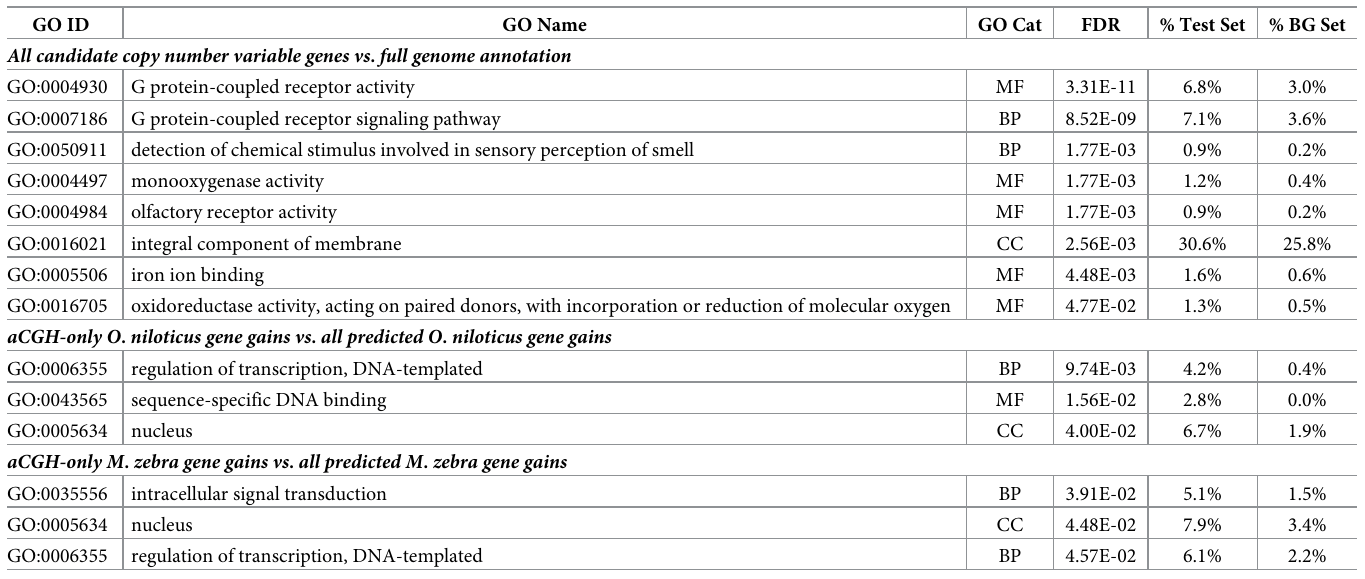
Table 1. Gene Ontology (GO) enrichment for gene subsets.